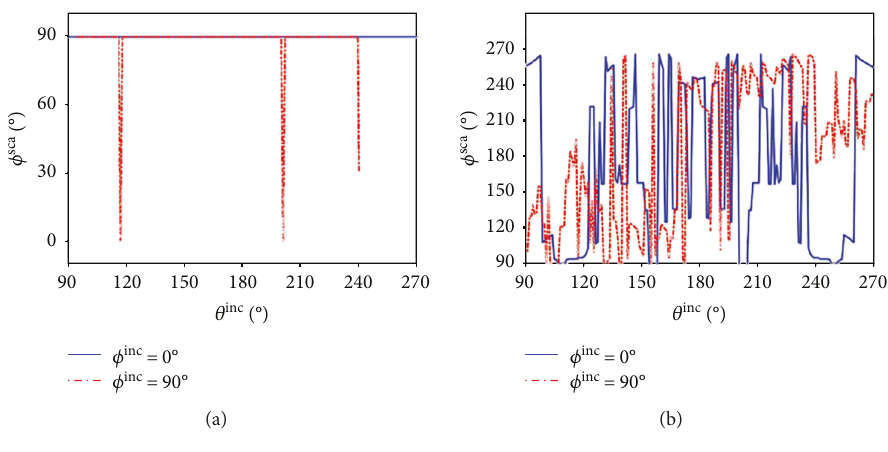
Figure 11: Direction of the minimum RCS ( α = 0 ).